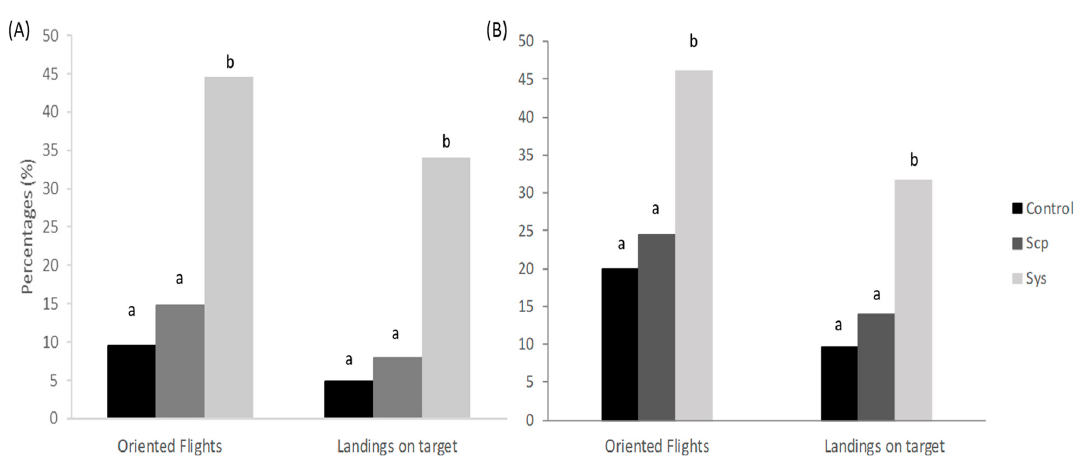
Figure 6. Flight behaviour of the aphid parasitoid Aphidius ervi towards tomato plants treated with Sys, Scp, and untreated (control) on intact leaves ( A ) or in hydroponics ( B ). Values indicate the percentage of females showing oriented flights and landings on source. Each assay was conducted using at least 100 females tested against 9 plants. Different letters indicate significant differences (G-test, p < 0.05). Table 1. Volatile organic compounds (VOCs) increase upon treatment with the systemin peptide. List of VOCs significantly improved by Sys foliar application in comparison to VOCs blend released by mock- and Scp-treated plants (* p < 0.05, Kruskal-Wallis One Way ANOVA). Concentration (PPb)